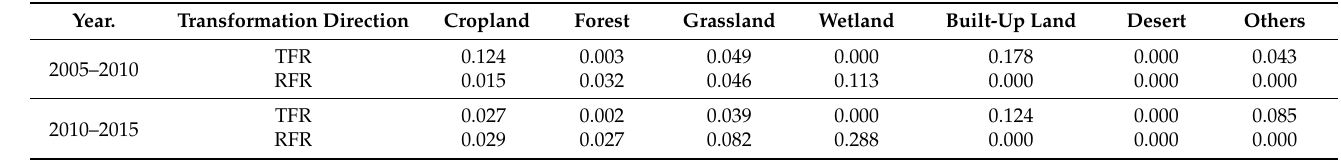
Table 5. Forward/reverse conversion rate in the NFB.